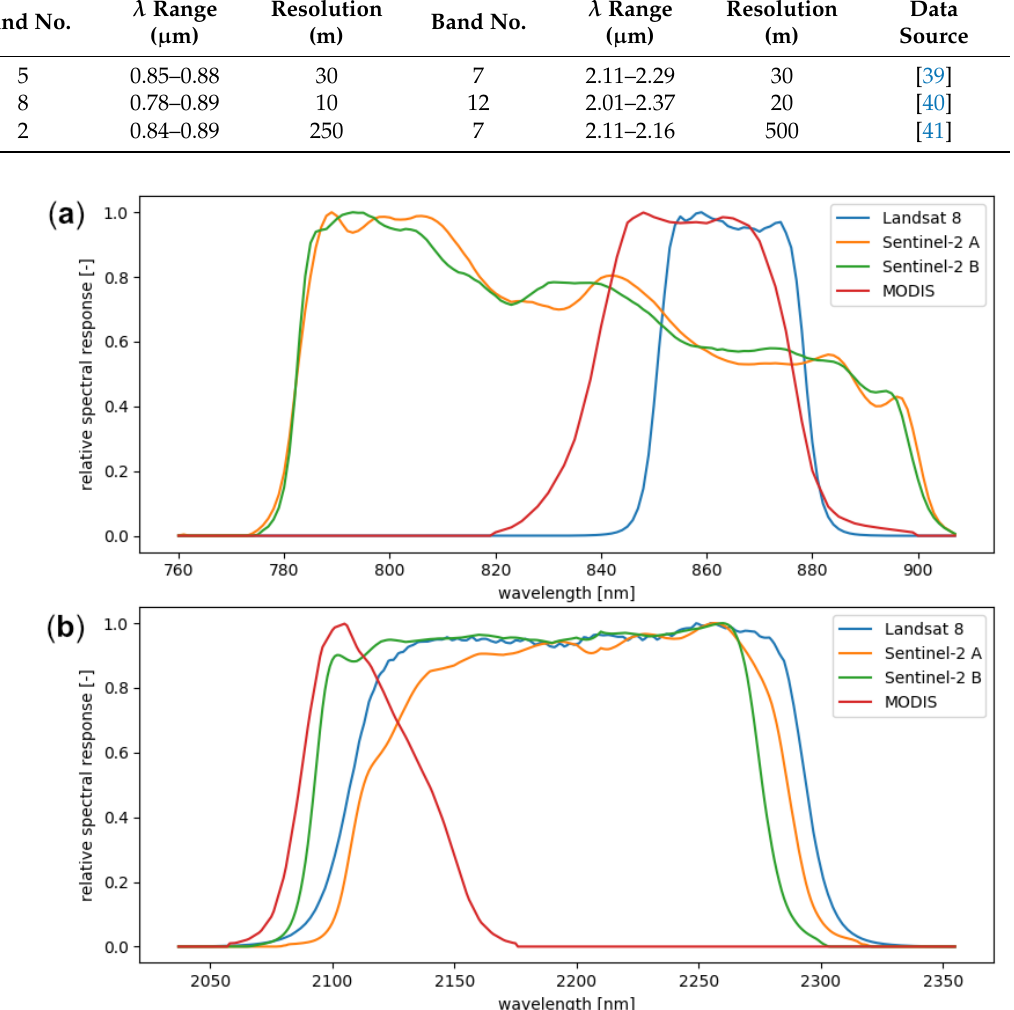
Table 3. Details of the satellite instrument bands used in the analysis. Used are the near-infrared (NIR) and shortwave-infrared (SWIR) bands for Landsat 8, Sentinel-2 (two satellites; A and B), and the Moderate Resolution Imaging Spectroradiometer (MODIS, two satellites; Terra and Aqua). NIR Band SWIR Band λ Range Satellite Instrument Band No.